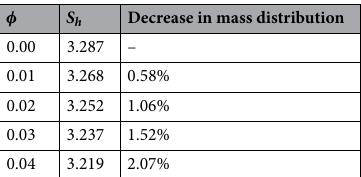
Table 4. Sherwood number for EO-based Cadmium